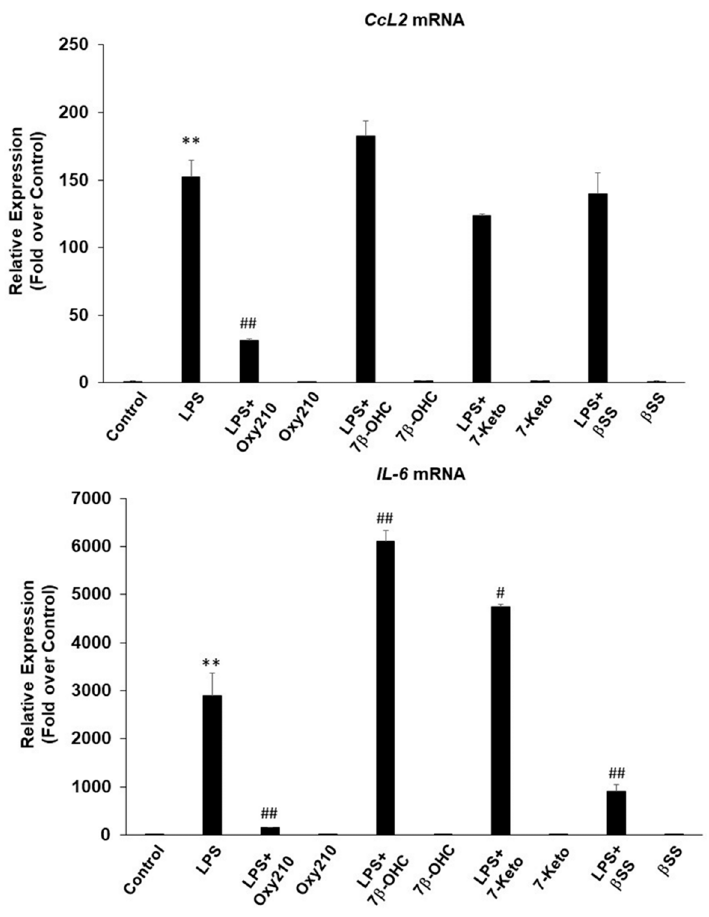
Figure 8. Comparison of Oxy210 with naturally occurring sterols and oxysterols for their inhibitory effects on LPS-induced inflammatory gene expression in RAW264.7 macrophages. RAW264.7 cells were pretreated with the compounds (5 μ M) as indicated in DMEM containing 0.1% FBS for 24 h followed by the addition of LPS (25 ng/mL) in the absence or presence of the compounds (5 μ M). After 24 h, RNA was extracted and analyzed by Q-RT-PCR for the expression of the genes as indicated and normalized to Oaz1 expression. Data from a representative experiment are reported as the mean of triplicate determinations ± SD (** p < 0.01 vs. control; # p < 0.05 vs. LPS; ## p < 0.01 vs. LPS).